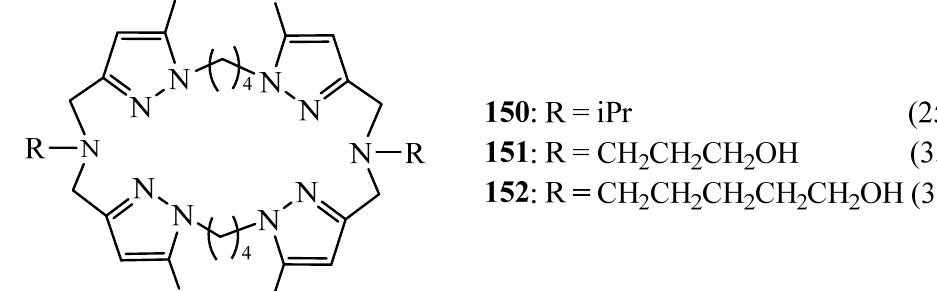
Figure 41. Other tetrapyrazolic macrocycles 150 − 152 with two sidearms.